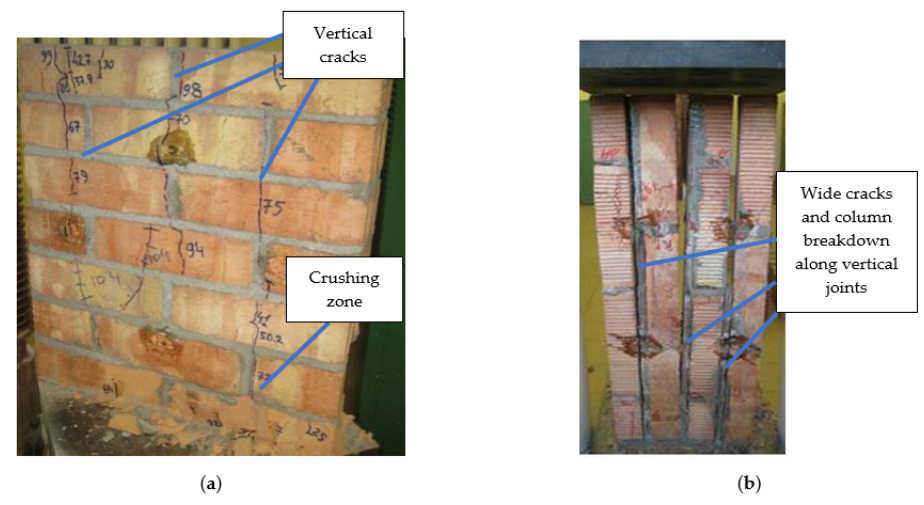
Figure 12. Failure mechanism of wall specimens θ = 0° ( a ) and θ = 90° ( b ).